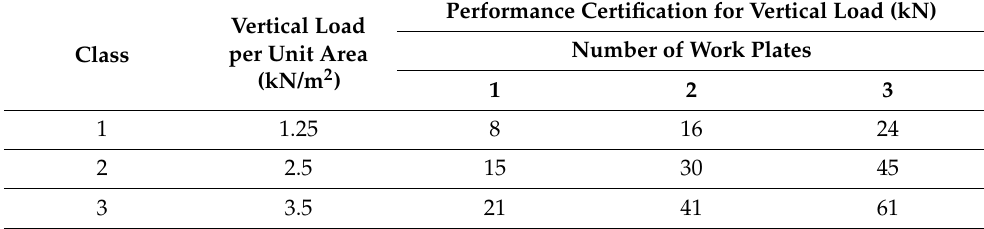
Table 15. Example of maximum load according to the work class for vertical load and number of steps of the working platform. Performance Certification for Vertical Load (kN) Vertical Load Number of Work Plates per Unit Area Class (kN/m 2 ) 1 2 3